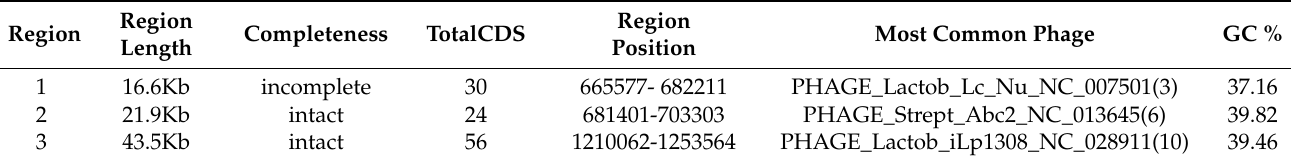
Table 2. Prophage information of Pediococcus acidilactici